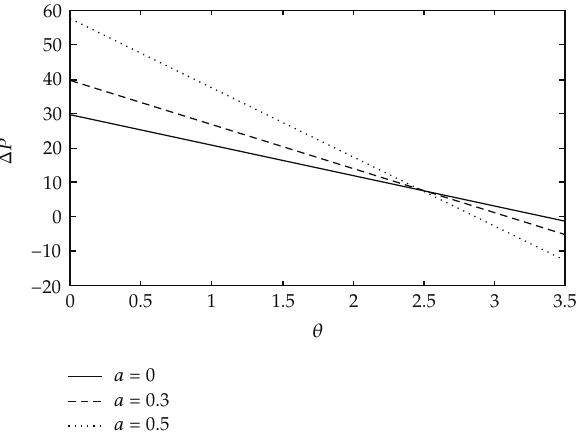
Figure 5: The pressure rise verses flow rate when α (cid:9) 0 . 01, a (cid:9) 0 . 4, b (cid:9) 0 . 6 , d (cid:9) 0 . 8 , ε (cid:9) 0 . 4 , λ 1 (cid:9) 0 . 5, and Da (cid:9) 0 . 5.